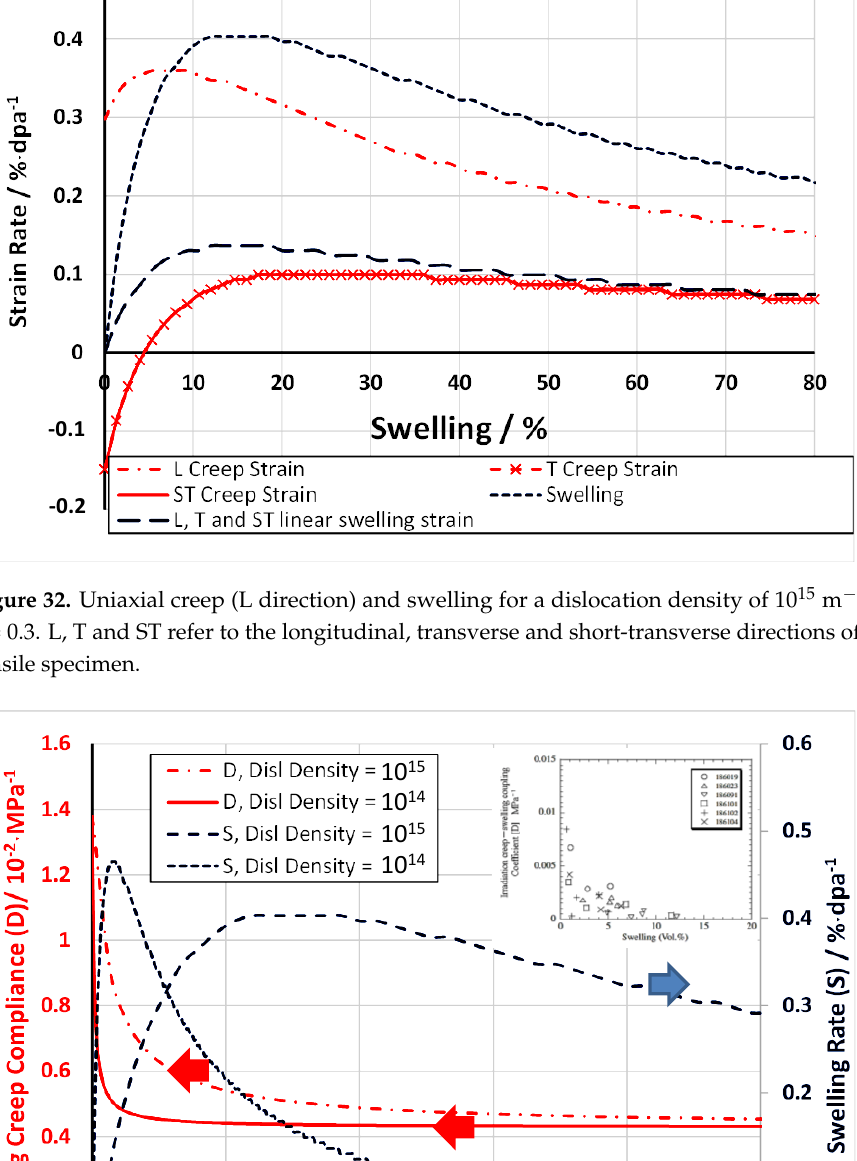
Figure 33. Creep Compliance and swelling under stress for a dislocation density of 10 15 m −2 and of 10 14 m −2 . Assumes s = 0.15 is equivalent to 100 MPa. Inset—experimental data for D [95], corresponding with the calculated values for D shown in red.